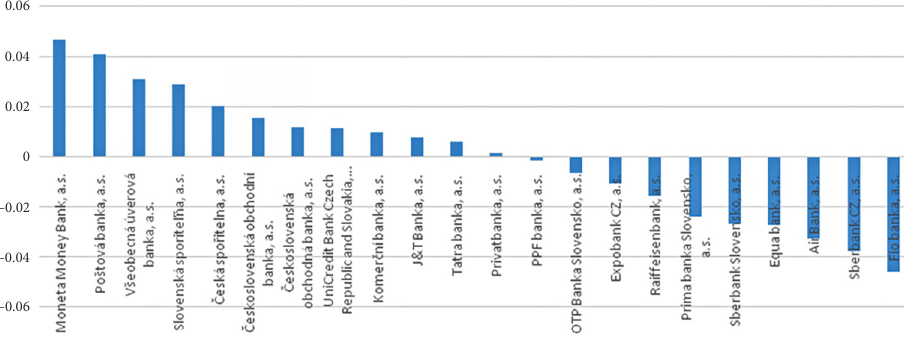
Fig. 5. Ranking of the analyzed Czech and Slovak banks according to the obtained PROMETHEE